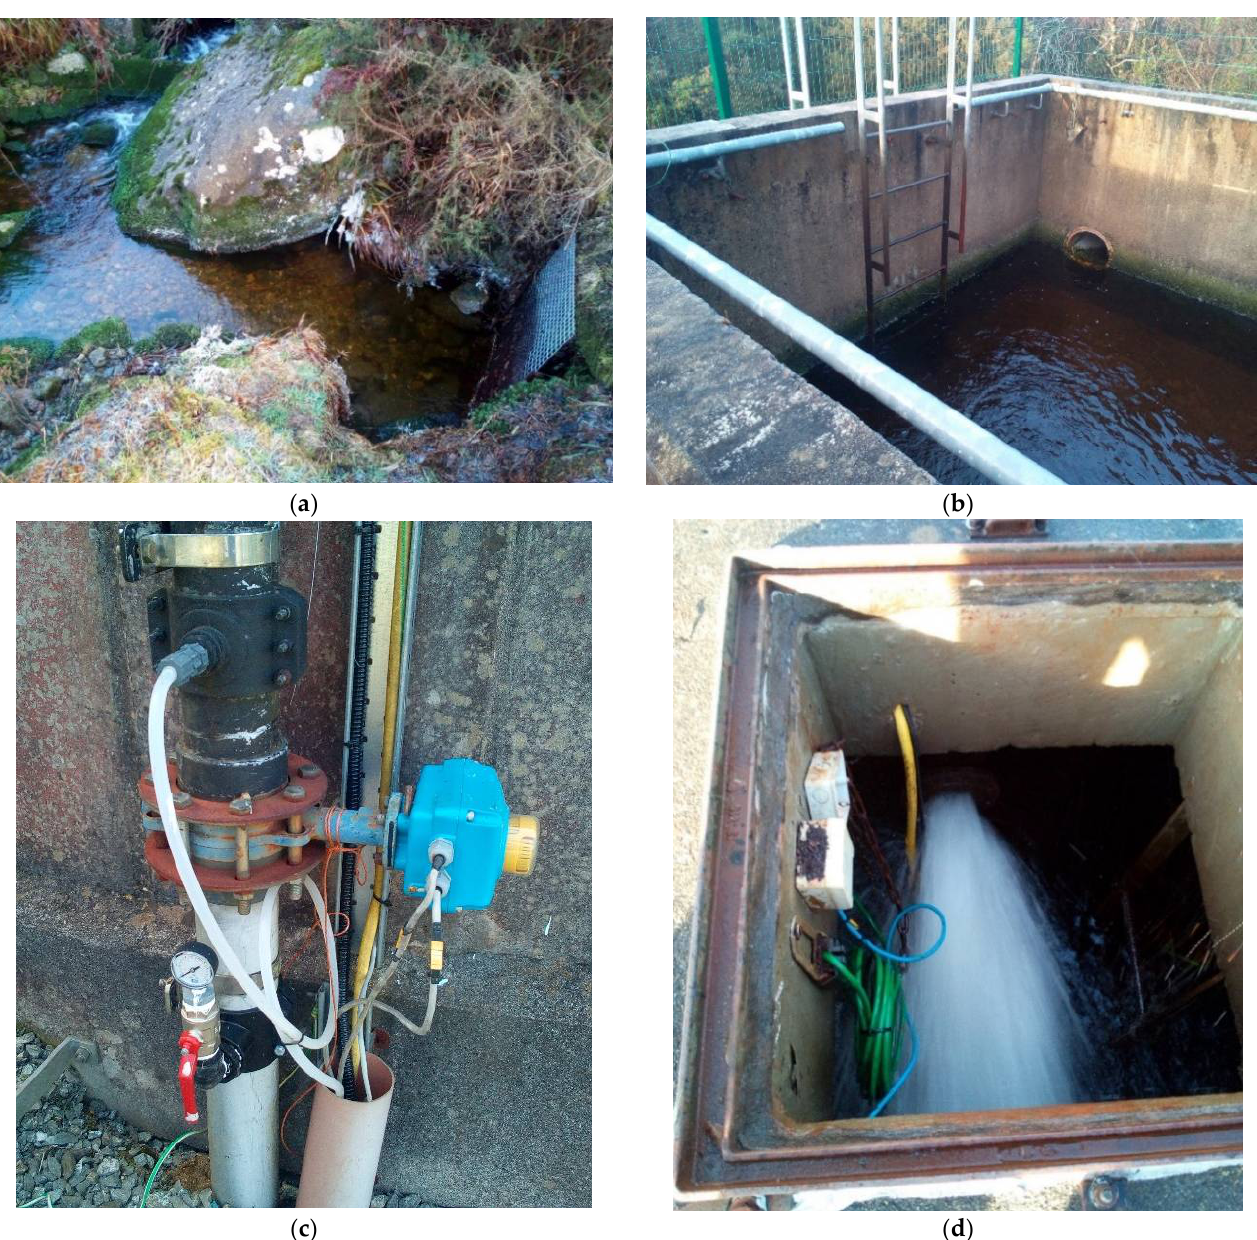
Figure 3. Portions of the Connells supply line. ( a ) River intake with screening mesh. ( b ) Settling tank at the start of the penstock. ( c ) The base of the raw water storage tank at the WTP, with visible on/off automated butterfly valve. ( d ) Water flow entering the tank.